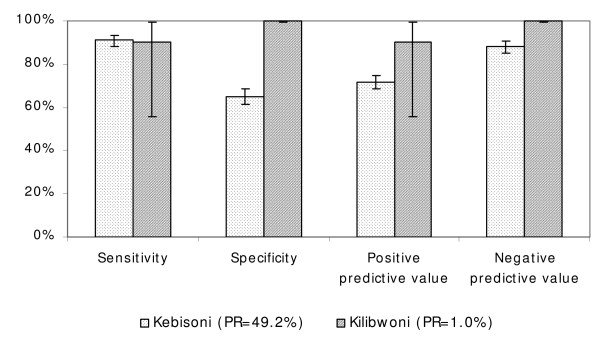
Sensitivity, specificity, PPV and NPV of RDTs compared to microscopy in Kebisoni (mesoendemic area) and Kilibwoni (hypoendemic area). Error bars indicate 95% confidence intervals.